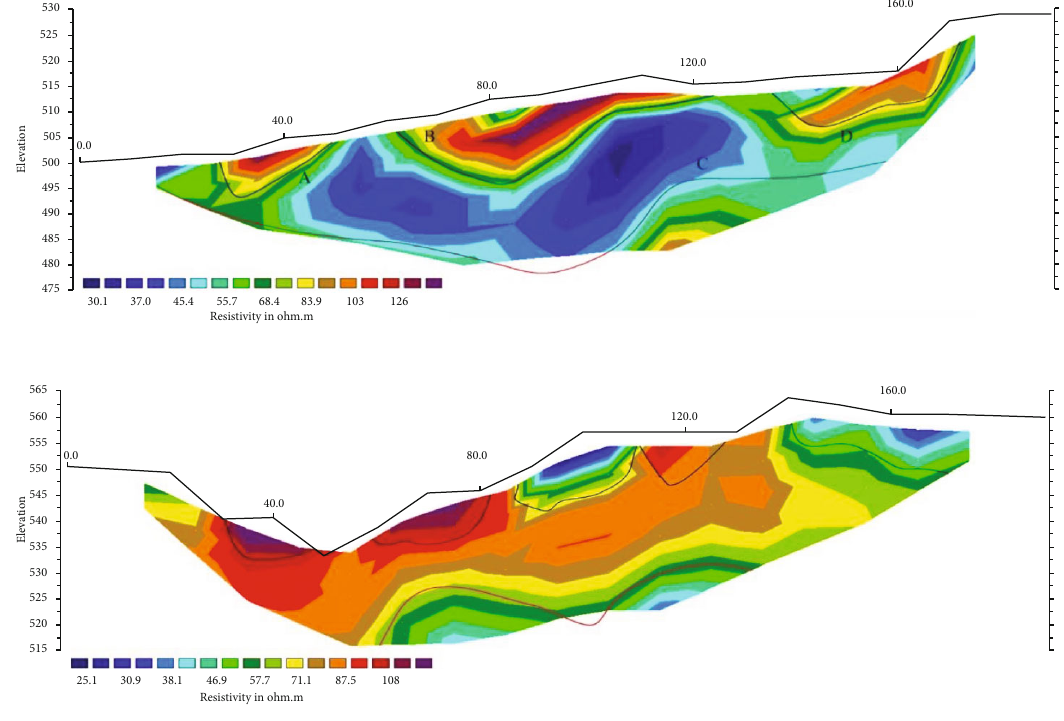
Figure 15: Measurement results in summer.